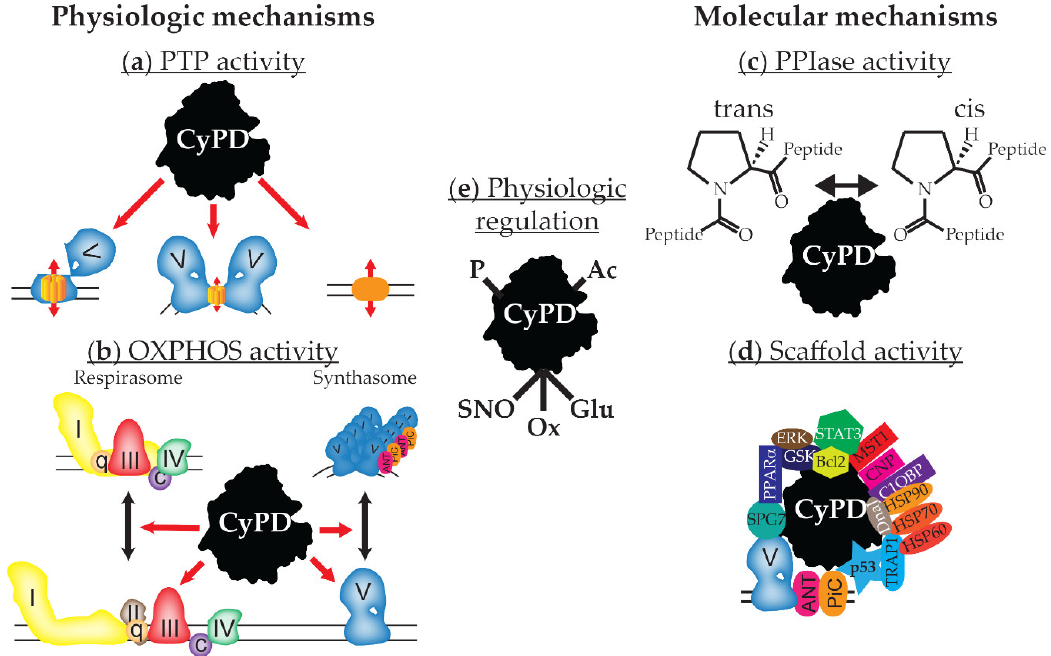
Figure 1. A model of the molecular and physiologic mechanisms of cyclophilin D (CyPD)’s action and regulation. ( a ) The major known physiologic function of CyPD is regulation of the mitochondrial permeability transition pore (PTP). It remains unclear how CyPD regulates the three models of the PTP presented: the c ring of ATP synthase ( left ), dimers of ATP synthase ( middle ), and an unknown entity in the inner mitochondrial membrane ( right ). ( b ) Data also suggests that CyPD may regulate oxidative phosphorylation (OXPHOS) activity, perhaps altering the activity of the respiratory chain and respirasome assembly and inhibiting the activity of ATP synthase and synthasome assembly (electron transport chain (ETC) complexes and ATP synthase are labeled with their complex number, while q and c designate coenzyme q/ubiquinone and cytochrome c , respectively. ( c ) CyPD is a peptidyl-prolyl, cis - trans isomerase (PPIase) that resides in the mitochondrial matrix, but the targets of this PPIase activity are poorly defined. ( d ) CyPD also functions as a scaffold protein, bringing various structural and signaling molecules together to effect changes in mitochondrial physiology. ( e ) CyPD’s activity is regulated by its expression, which is developmentally regulated in some organs, and its post-translational modification, shown as phosphorylation (P), acetylation (Ac), S -nitrosation (SNO), oxidation (Ox), and S -glutathionylation